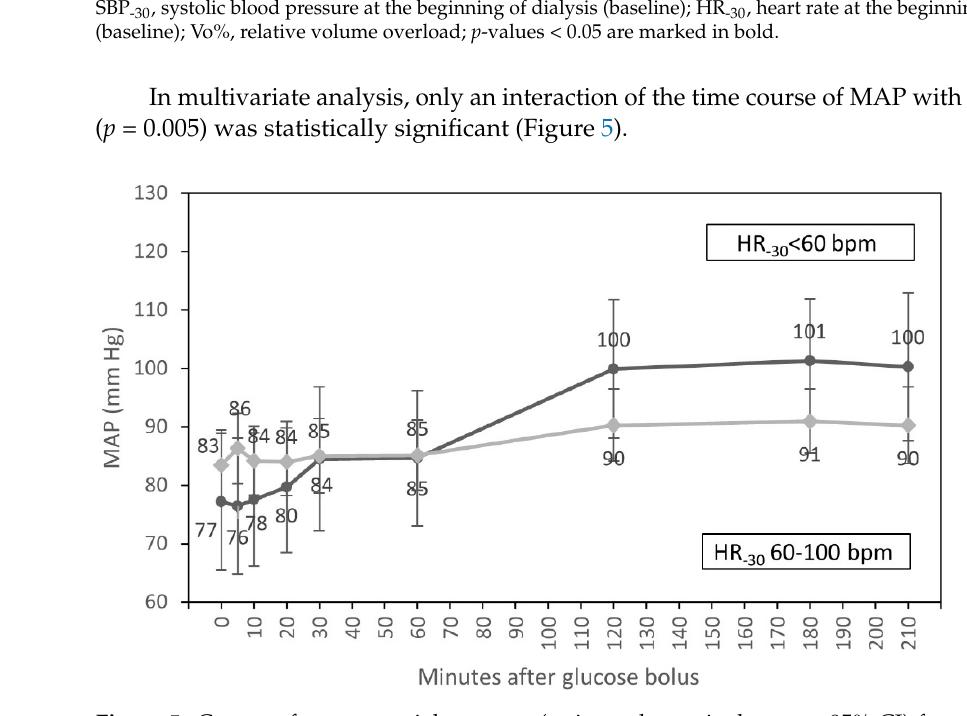
Figure 5. Course of mean arterial pressure (estimated marginal means, 95% CI) for groups with HR < 60 bpm and HR from 60 to 100 bpm at the beginning of hemodialysis, adjusted for diabetic status.